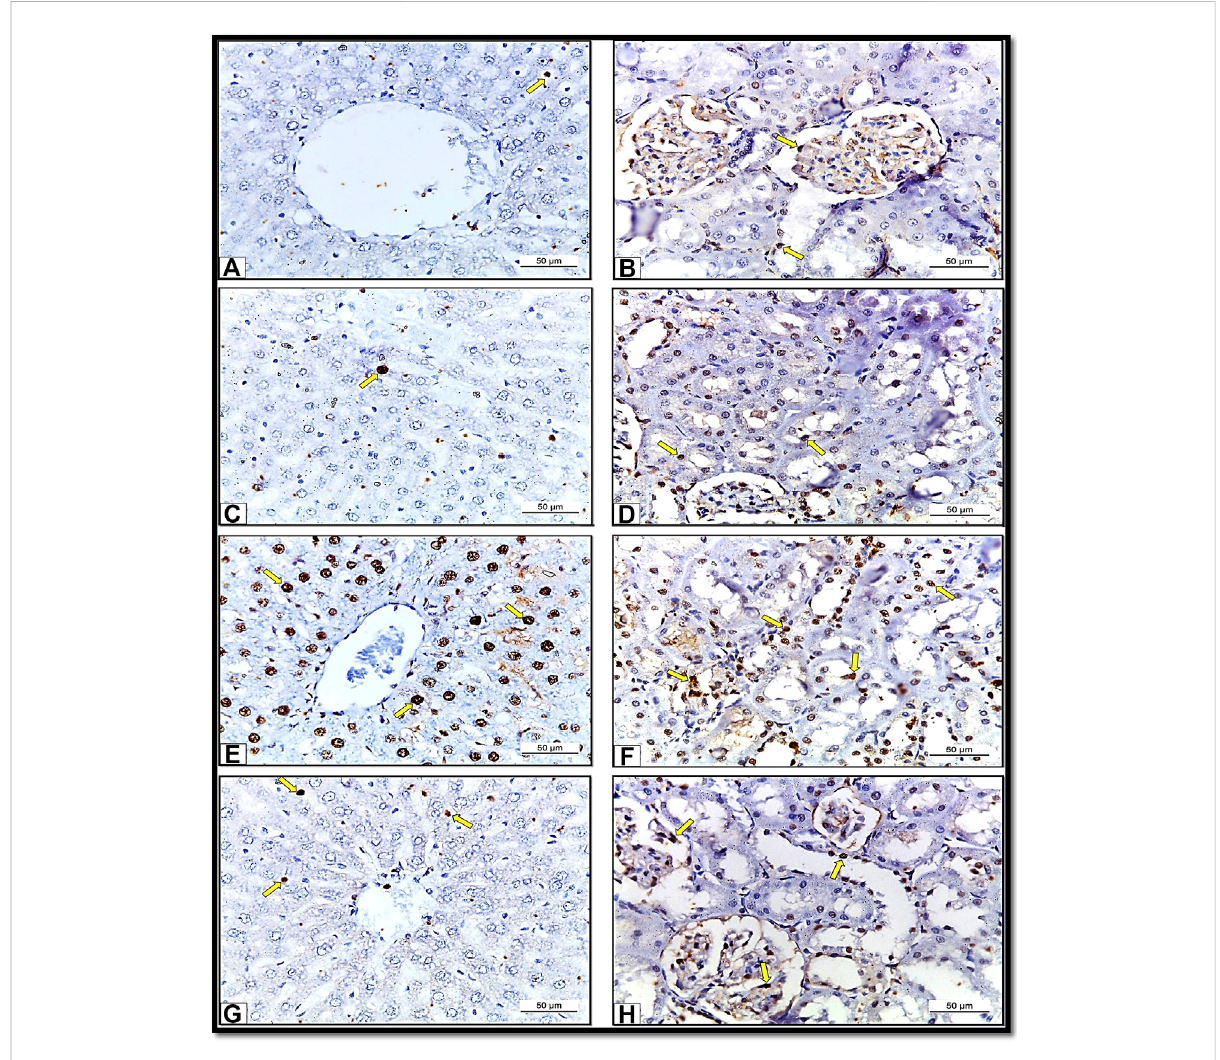
immunoreaction. X 400. Sections of liver (Fig. 9E) and Kidney (Fig. 9F) of NiO-NPs-exposed (Group II) showing strong PCNA immune-reactivity. X400. Sections of liver (Fig. 9G) and Kidney (Fig. 9H) of HSP+NiO-NPs-exposed (Group IV) showing moderate PCNA